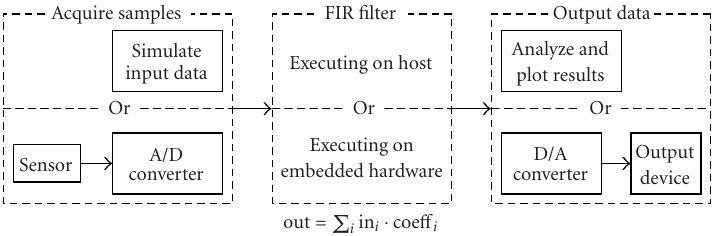
Figure 2: A fully developed system prepared for simulation on a host workstation to check the system’s performance and correctness, for execution on embedded hardware to validate the system’s real-world characteristics, or for a combination of both to better analyze the performance of the system.